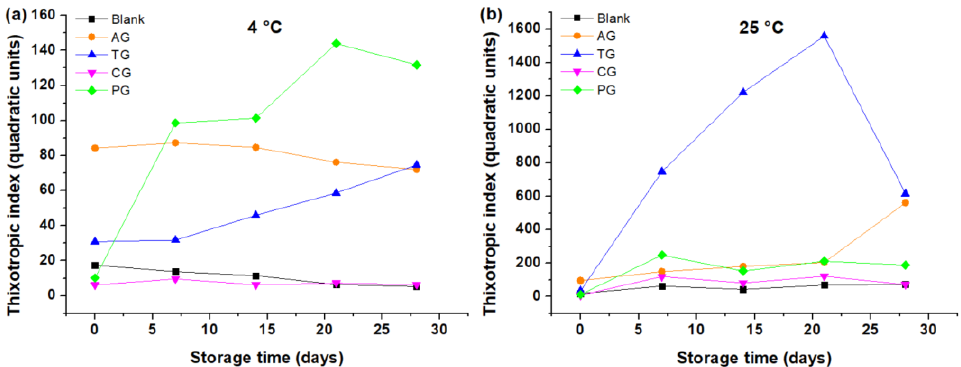
Figure 8. Thixotropic index as a function of the storage time of cake creams. ( a ) Creams stored at 4 °C; ( b ) creams stored at 25 °C.